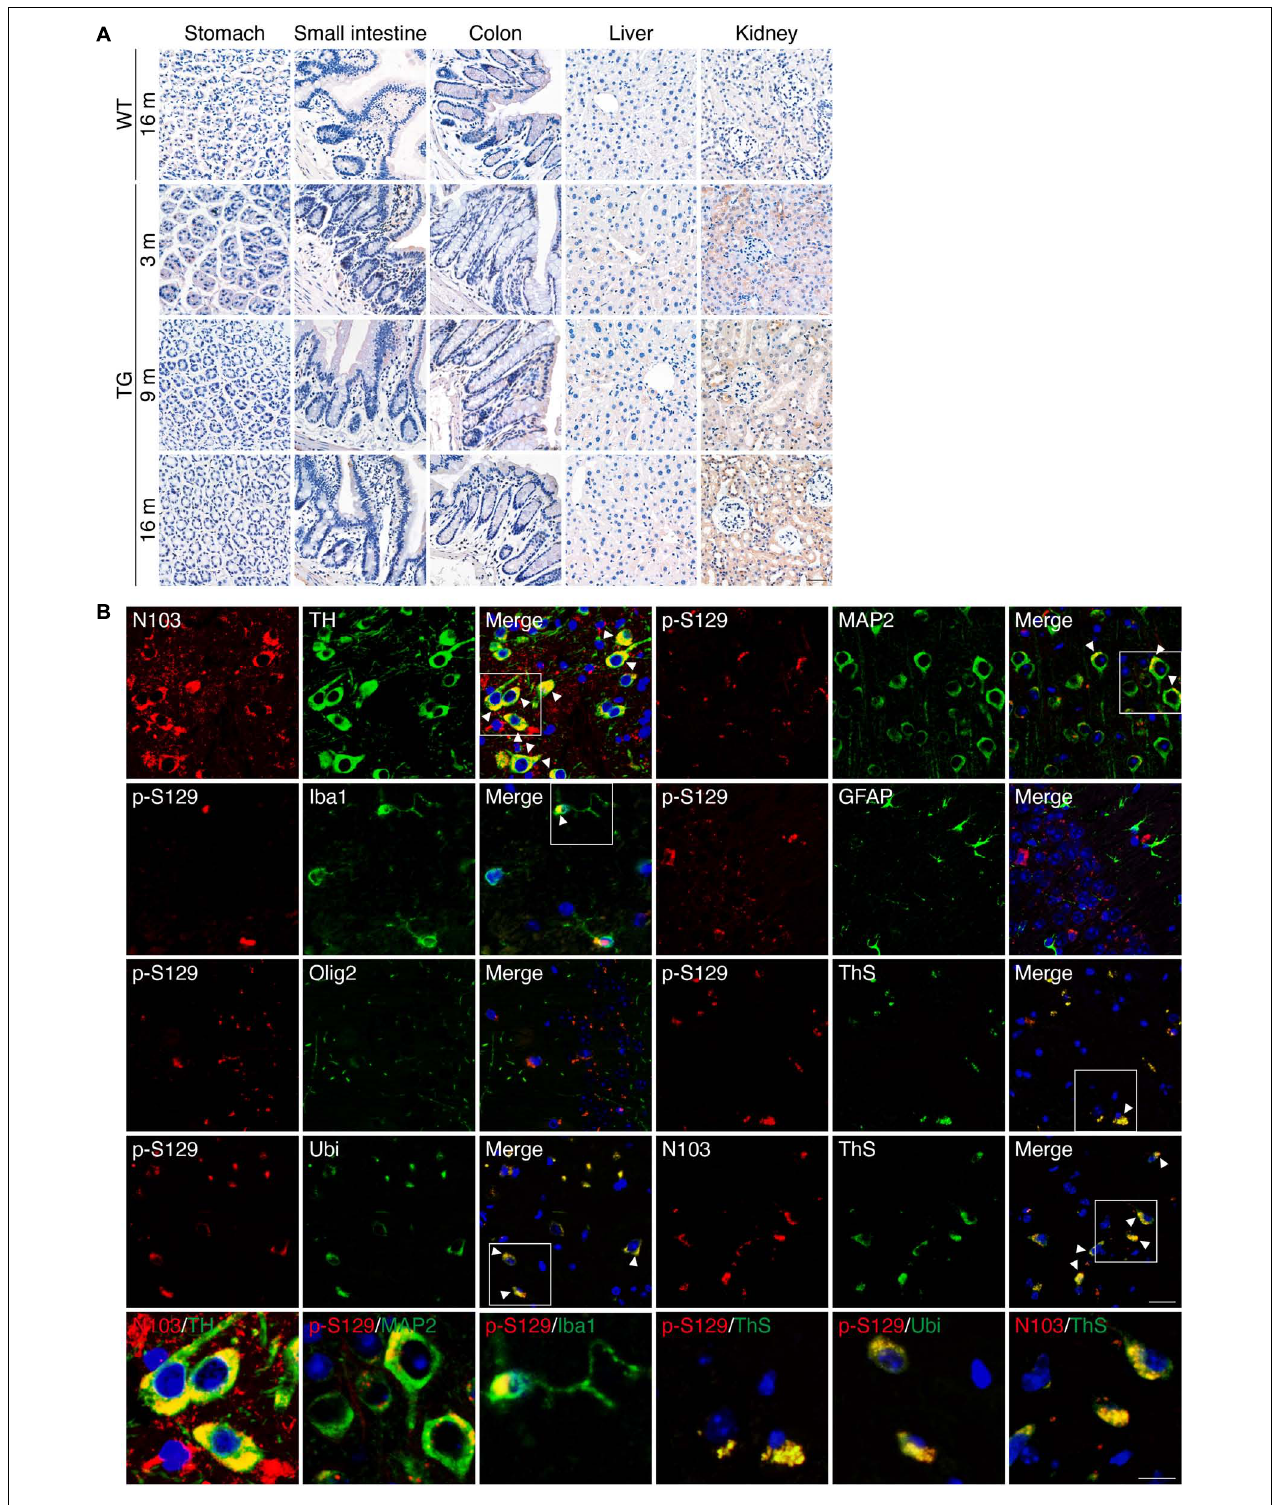
FIGURE 2 | PD-like pathology in N103 mice. (A) Immunohistochemistry of α -synuclein 1-103 fragment in non-neural tissues of WT mice and N103 mice. Scale bar, 40 µ m. (B) Double-label immunofluorescence of the substantia nigra, cortex, and hippocampus sections of 16-month-old N103 mice. α -synuclein 1-103 (red) and TH (green); α -synuclein p-S129 (red) and MAP2, Iba1, GFAP, Olig2, Ubiquitin, thioflavin-S (green); α -synuclein 1-103 (red) and thioflavin-S (green). Scale bar, 20 µ m. Colocalization is marked with white arrowheads and zoomed below. Scale bar, 10 µ m.